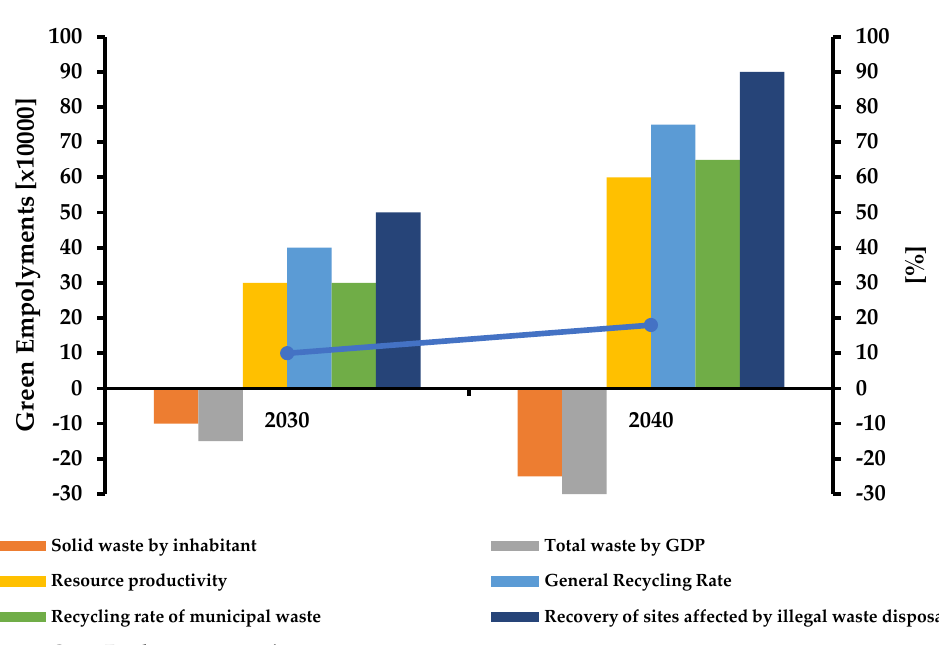
Figure 10. Long-term goals in Chile to implement a circular economy, adapted from [83].